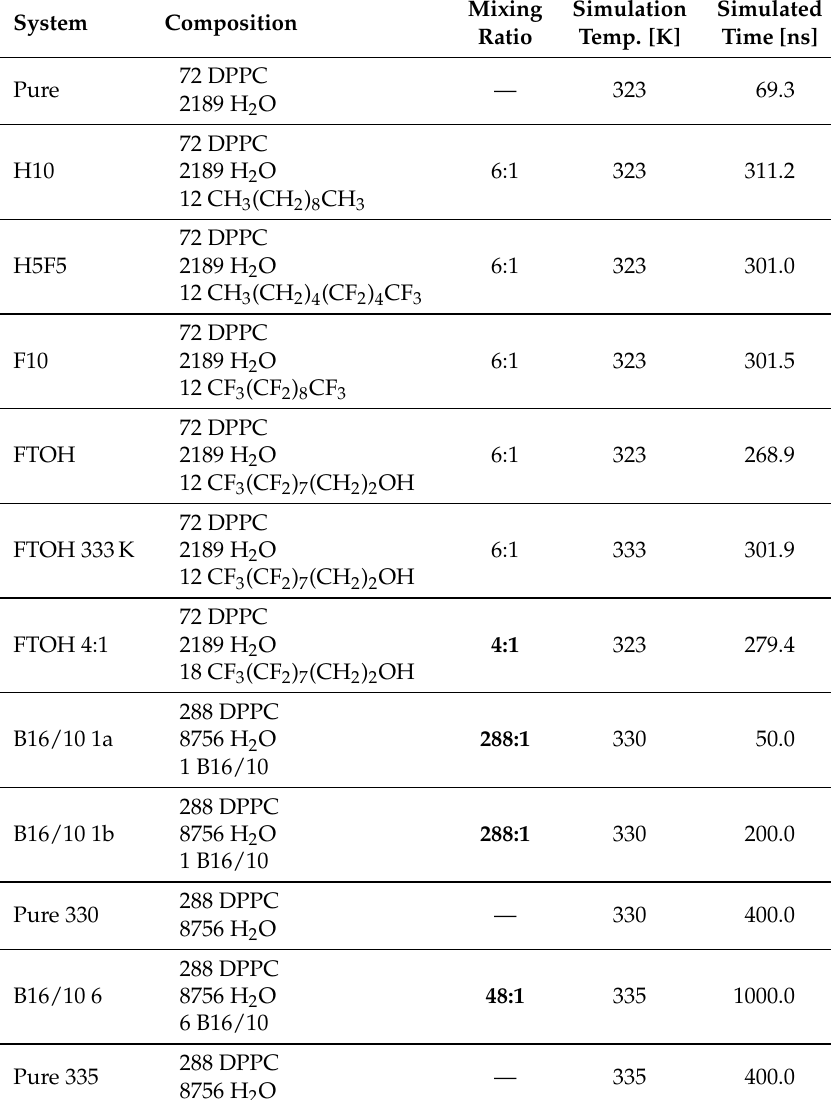
Table 1. Systems studied